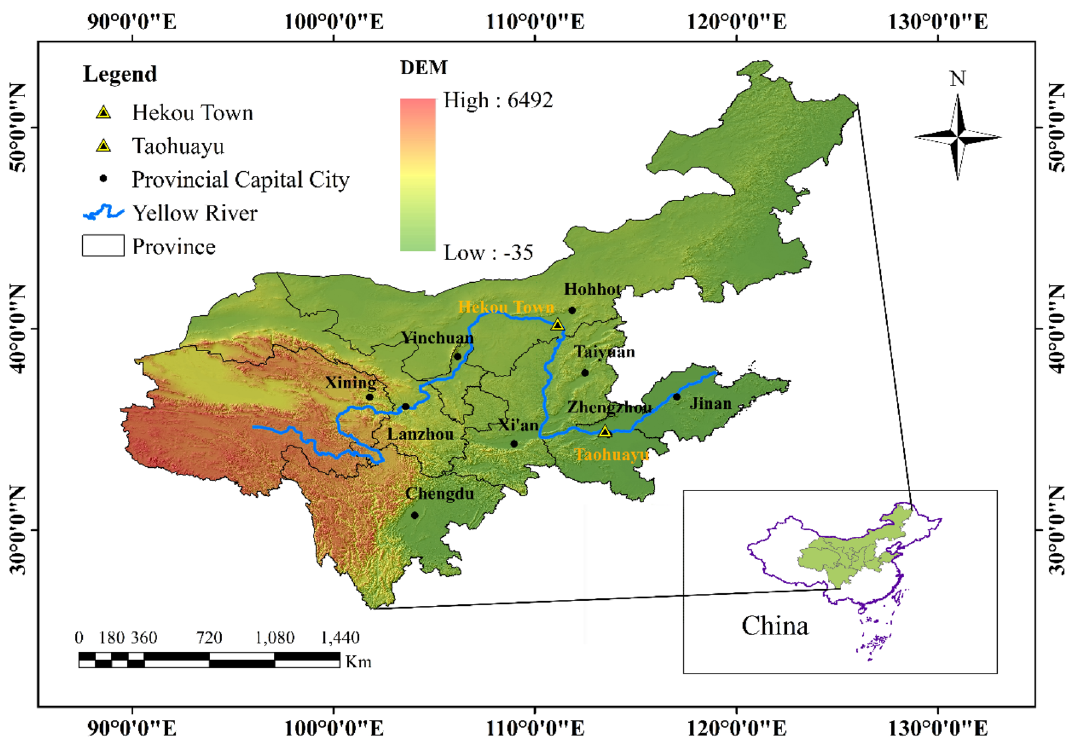
Figure 1. Geographical map of the Yellow River Basin. Note This was created by ArcMap-GIS, version 10.5. https:// www. esri.